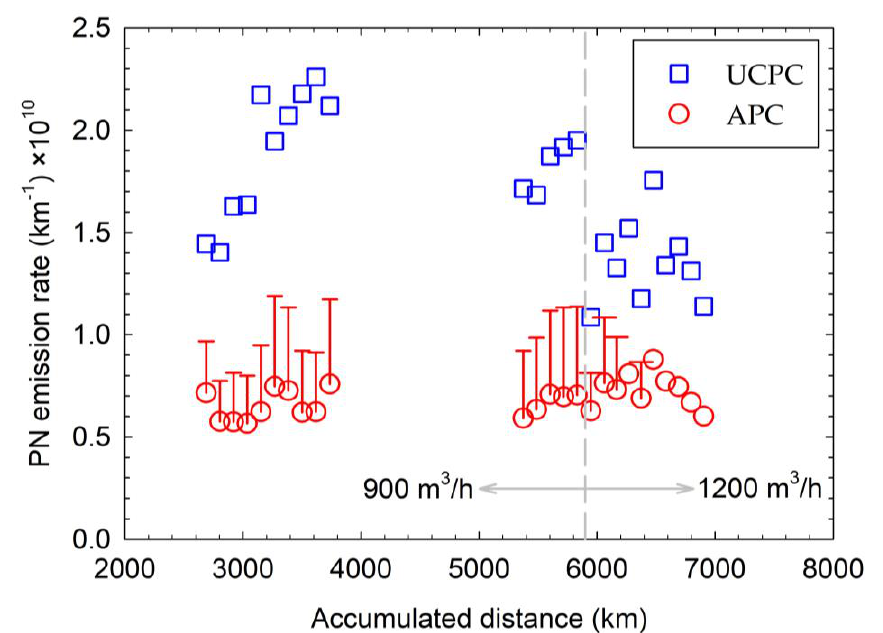
Figure 8. Evolution of thermally treated (red dots—APC) and untreated (blue dots—UCPC) PN emissions over several repetitions of the 3h-LACT cycle for conditioned pads as a function of the equivalent accumulated distance. The error bars on top of the APC results correspond to the undetected fraction due to losses inside the instrument and the larger detection limit of the internal CPC, based on the measured EEPS size distributions. The first 15 tests were performed at a tunnel flow of 900 m 3 /h and the last 10 tests at a flow of 1200 m 3 /h.